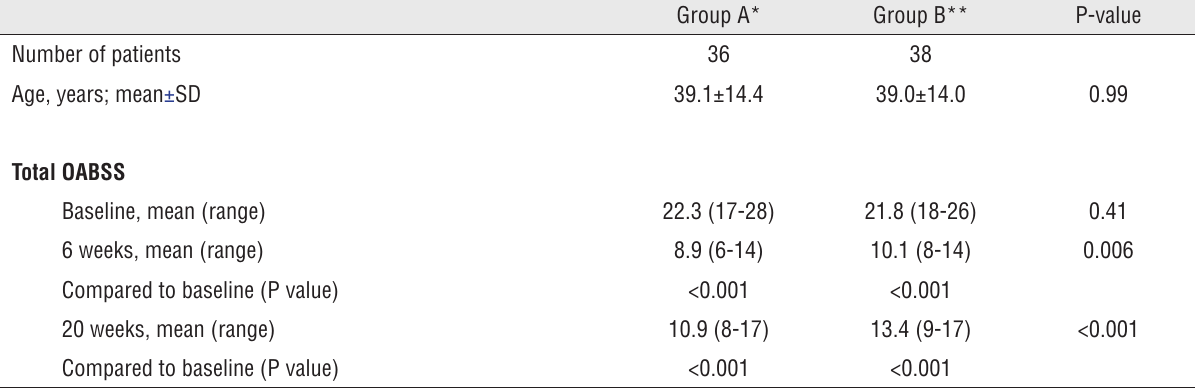
* Detrusor, trigone, bladder neck/prostatic urethra including injections ** Detrusor only